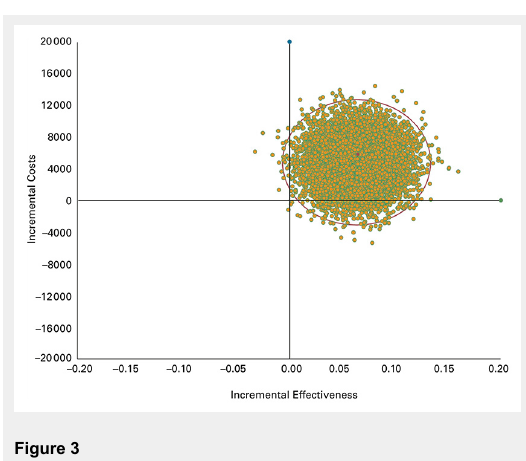
Scatter plot of incremental costs per person and incremental effectiveness derived from 10 000 iterations of the Monte Carlo simulation. Incremental effectiveness is expressed as quality adjusted life years (QALYs) gained and incremental costs are in CHF, from the societal